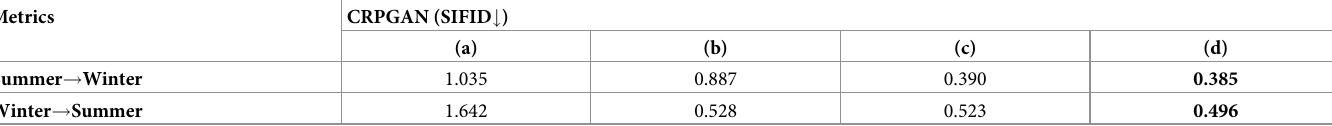
Table 1. Quantitative comparison between different order of channel and spatial attention η of CRPGAN in terms of SIFID. The best scores are in bold.